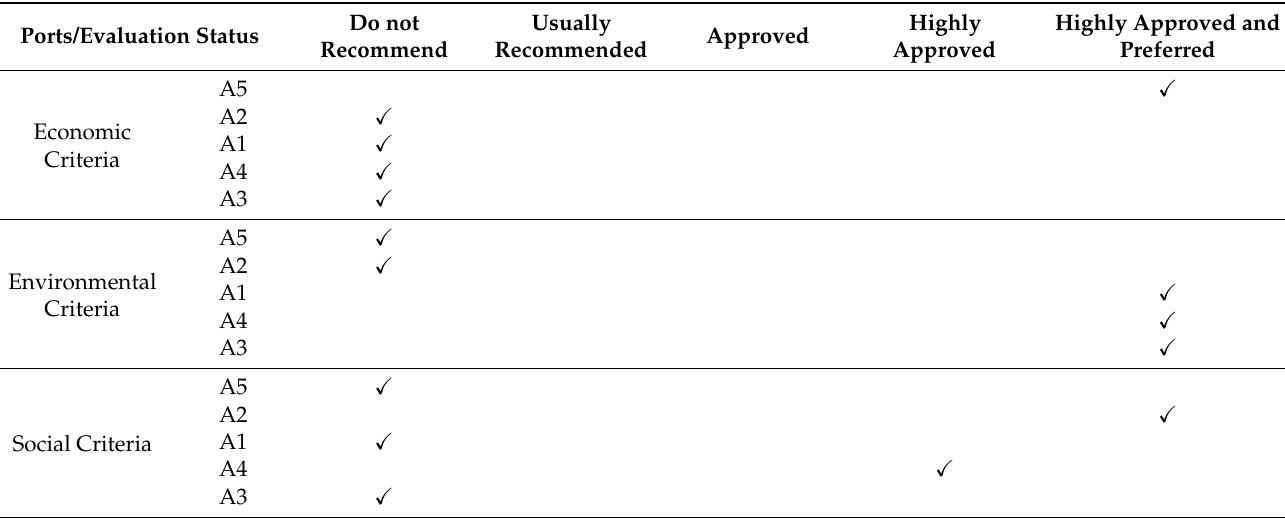
Table 8. Alternative class